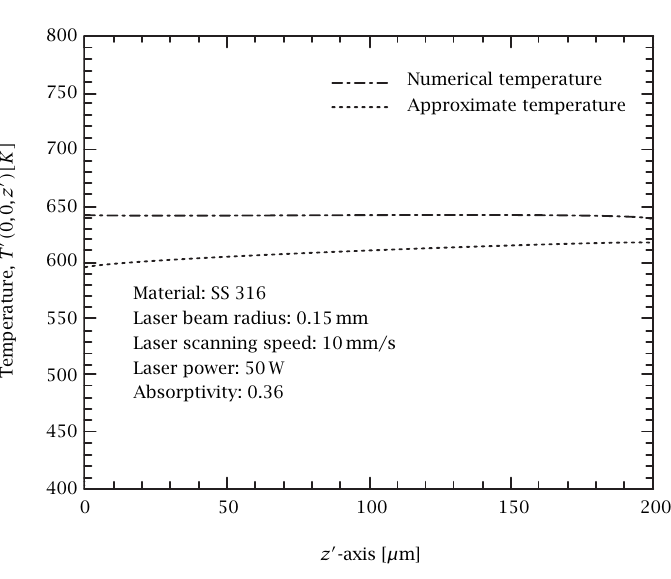
Figure 2.2 . Comparison between the numerical and approximate tempe- ratures ( r = 0 . 45mm